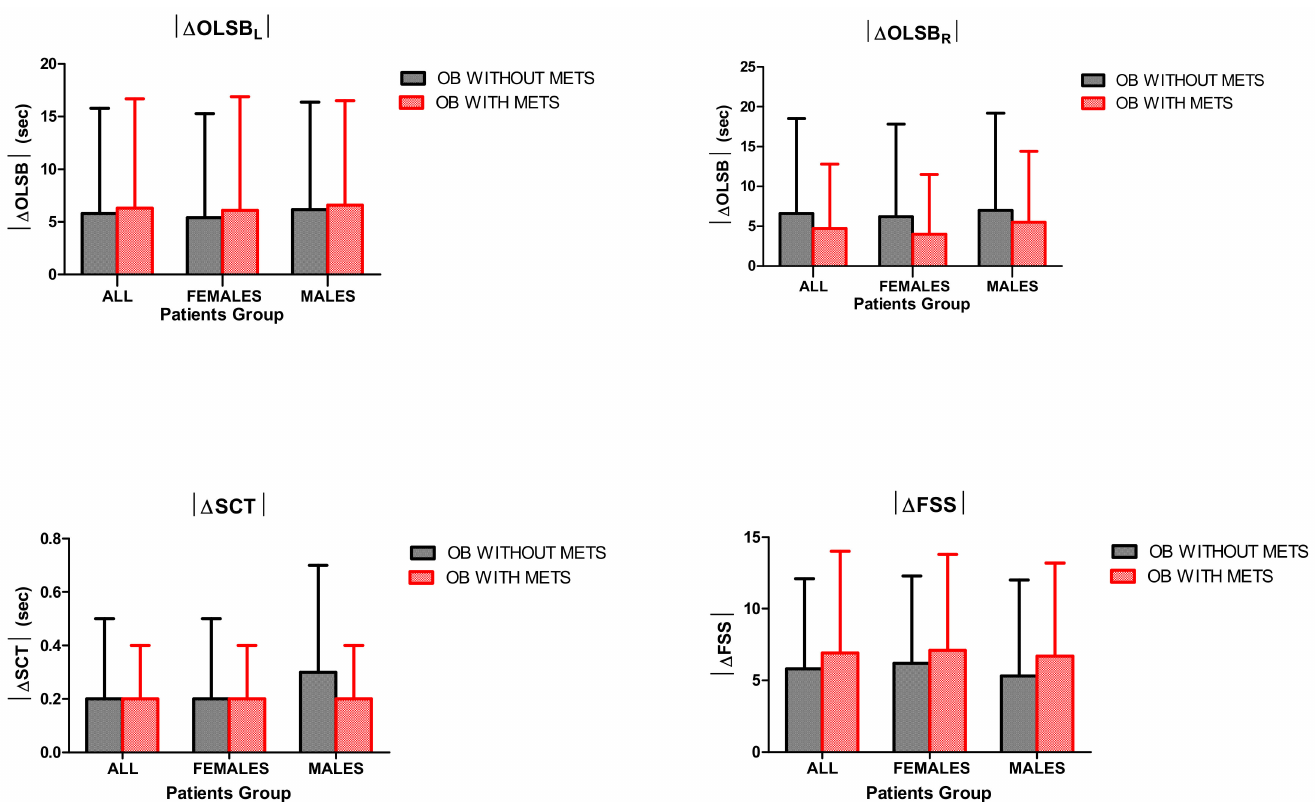
Figure 2. Absolute values of changes ( | ∆ | ) of changes of one-leg standing balance (for the left side, | ∆ OLSB L | , top left panel), | ∆ OLSB R | (for the right side, top right panel), stair climbing test ( | ∆ SCT | ) time (bottom right panel) and fatigue severity scale ( | ∆ FSS | ) score (bottom left panel), before and after a three-week body weight reduction program (BWRP) in obese (OB) children and adolescents with or without metabolic syndrome (METS). Data are expressed as mean ± SD. The values corresponding to each sex-related subgroup (females / males) are reported. All parameters were compared among all subgroups (all, females / males, obese with / without metabolic syndrome) before and / or after BWRP by using a Wilcoxon signed-rank test (two groups) or a Kruskal–Wallis one-way ANOVA on ranks (more than two groups), when